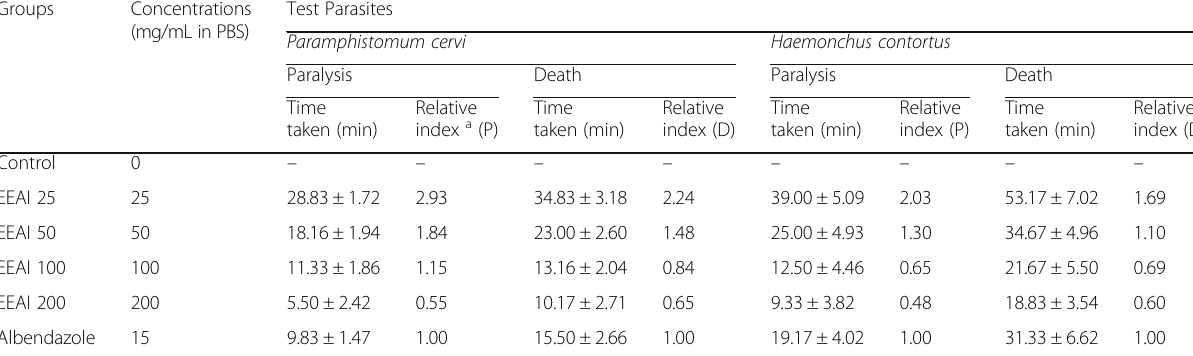
Table 3 Anthelmintic activity of different doses of Acanthus ilicifolius L.aerial parts against P. cervi and H. contortus